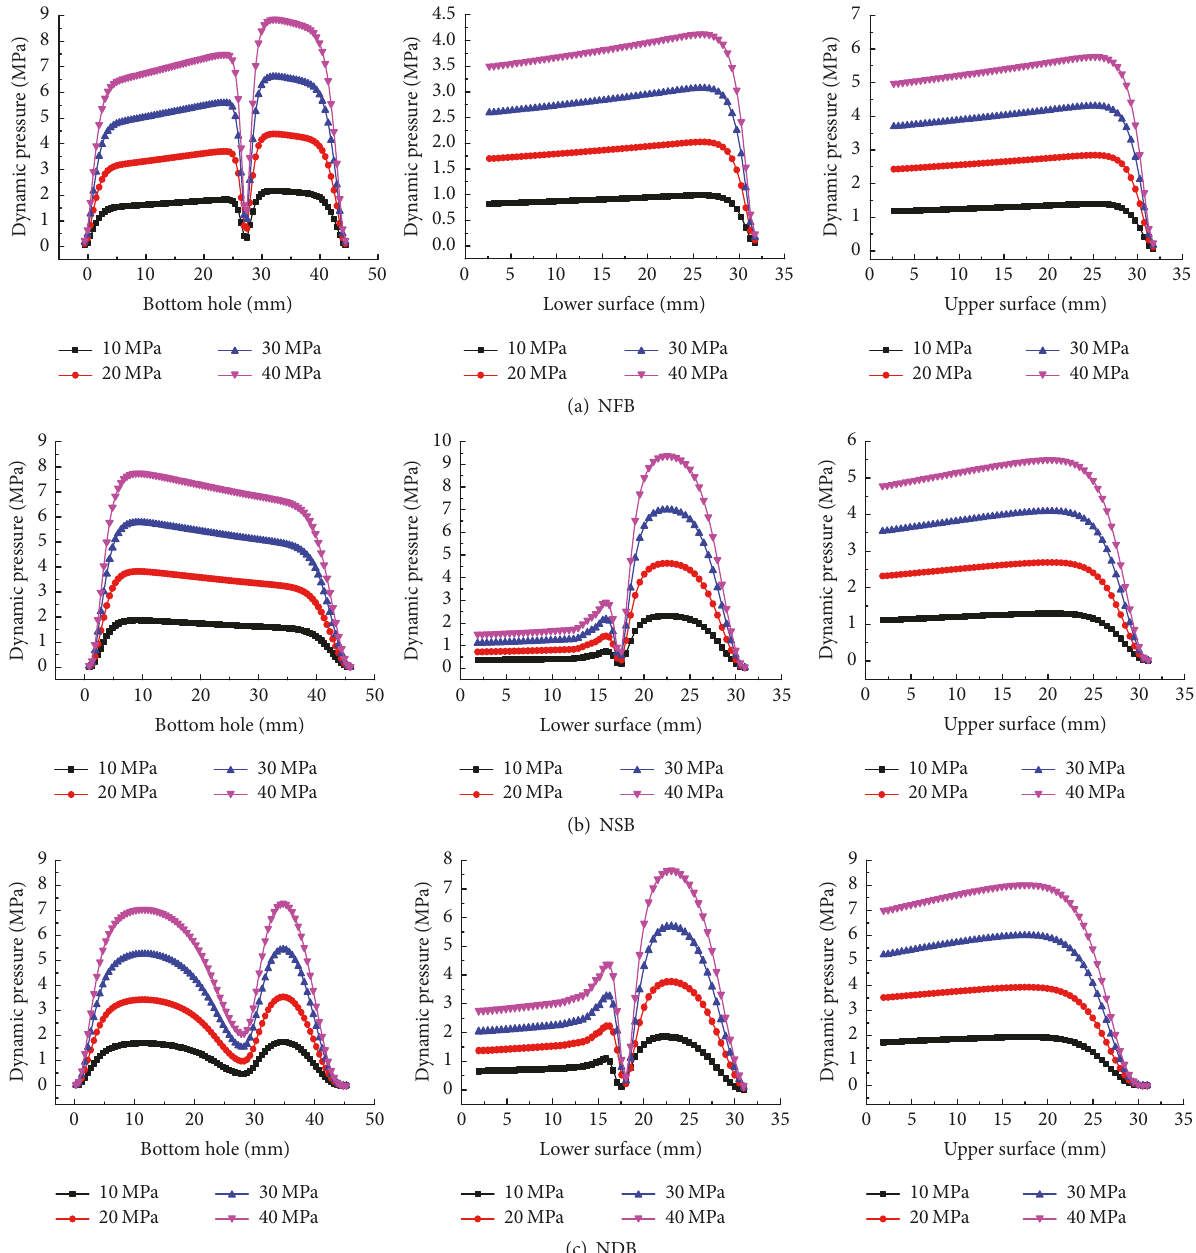
Figure 11: Distribution of dynamic pressure in bottom hole for different configuration